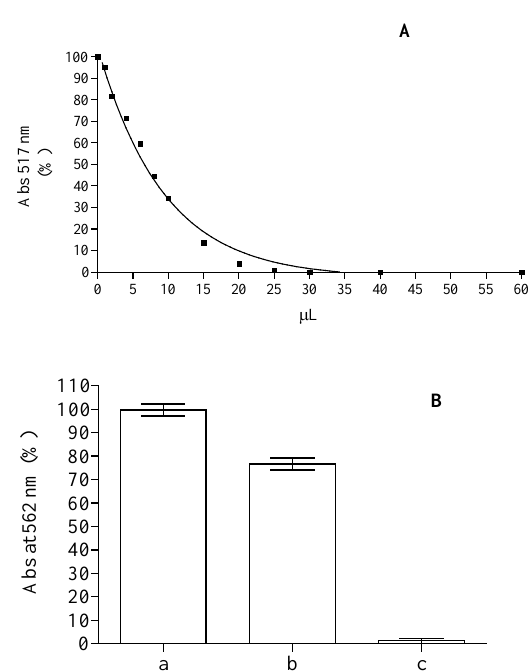
Figure 4. DPPH ( A ) and ferrozine assay ( B ) obtained with different amounts of Jatropha curcas L. methanol extract of Jatropha curcas L. leaves. Ferrozine assay without (a) or with 10 µL of methanol extract (b) or EDTA (c).